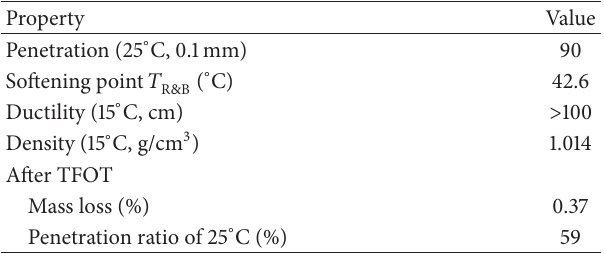
Table 1: Physical properties of neat asphalt.